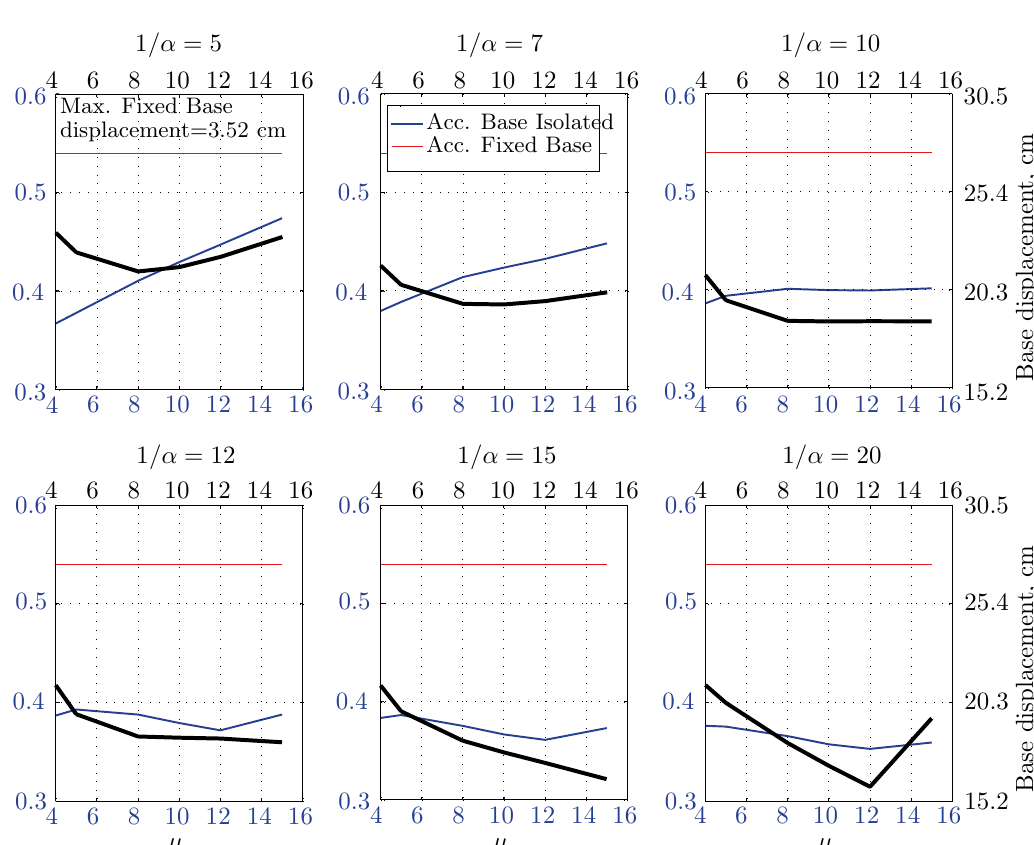
Figure 22. Peak responses of BI-structures subjected to Loma Prieta 1989 (Lexington dam